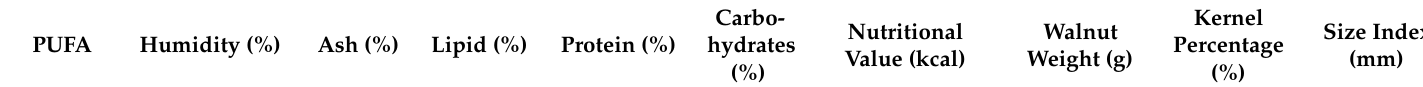
Table 7. Correlations between